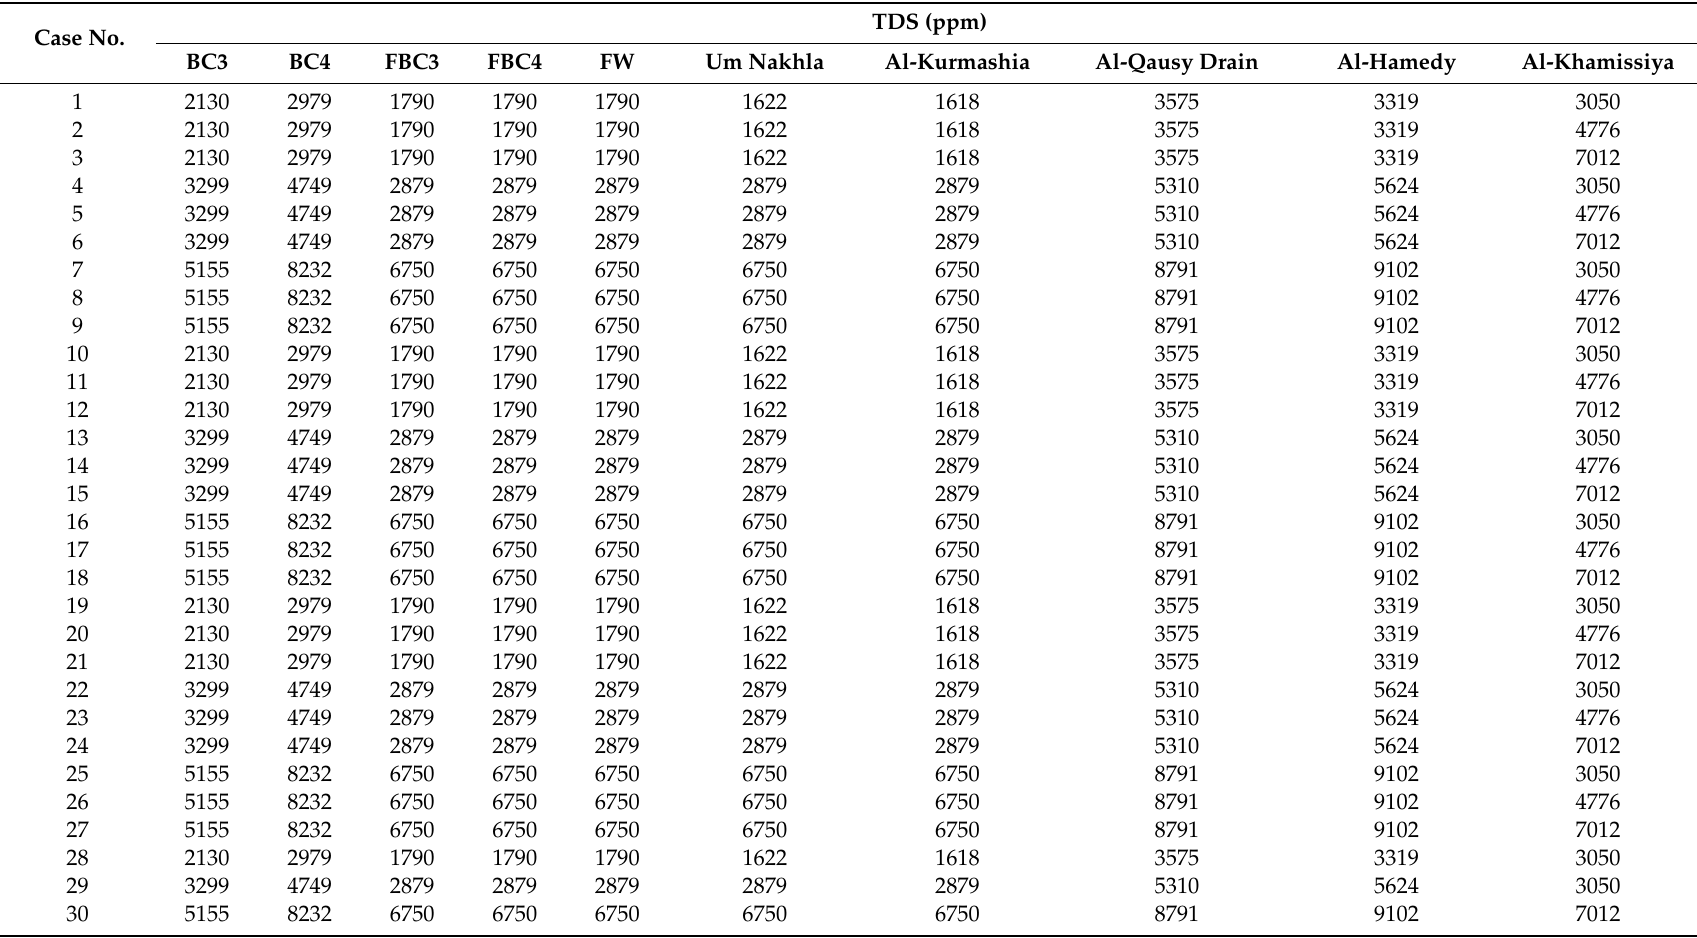
Table 3. Potential cases of marsh boundary conditions for the contaminant transport simulation model (CRIMW 2017 (unpublished data)). Case